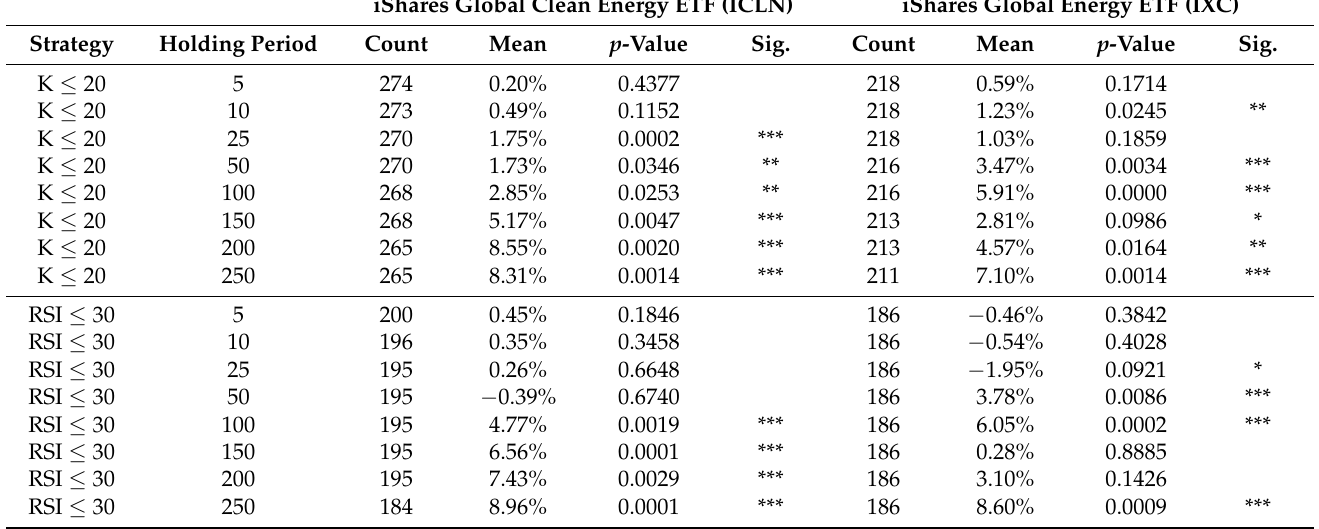
Table 4. Contrarian strategies for trading energy-related ETFs according to the SOI and RSI trading rules. By employing the financial commodities closely related to the performance of green energy (iShares Global Clean Energy ETF and its stock symbol is ICLN) or traditional energy (iShares Global Energy ETF and its stock symbol is IXC) over the data period 2010–2021, we then investigate whether these HRRs, including 5, 10, 25, 50, 100, 150, 200, and 250-day HPRs would be different from zero if investors employ contrarian strategies to buy these ETFs as the buying signals (i.e., oversold signals triggered by either SOI trading rules (i.e., K ≤ 20) or RSI trading rules (RSI ≤ 30). We also present the statistics of t -tests for these HPRs. In addition, *, **, and *** represent the 10%, 5%, and 1% significance levels, respectively. iShares Global Energy ETF